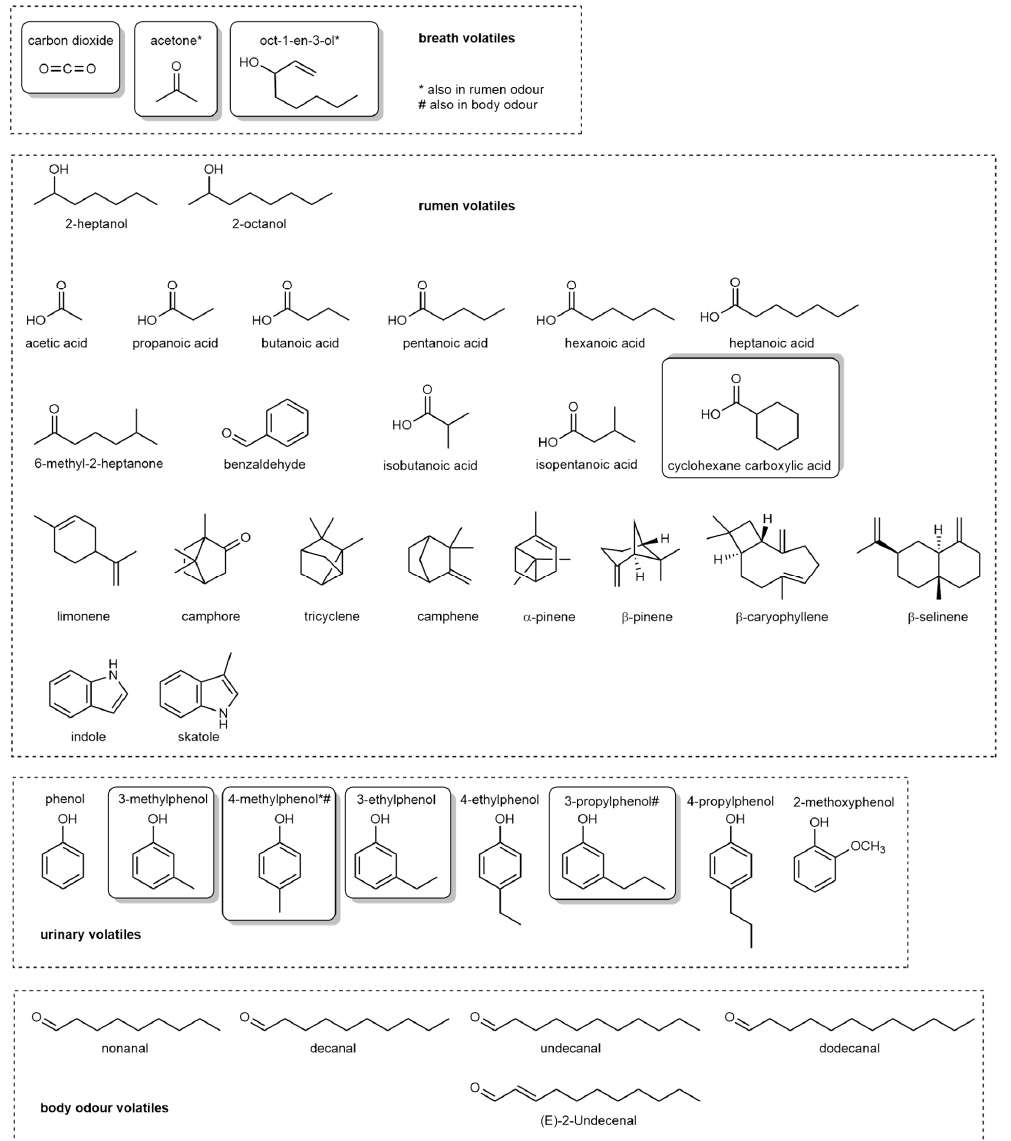
Figure 2. Olfactory attractants of tsetse flies ( Glossina ) from bovine volatile emissions. Broken outlines delineate the different odour compartments from which the analytes are emitted. Solid boxes identify chemical structures that have been shown to demonstrate both electroantennographic and behavioural activity.